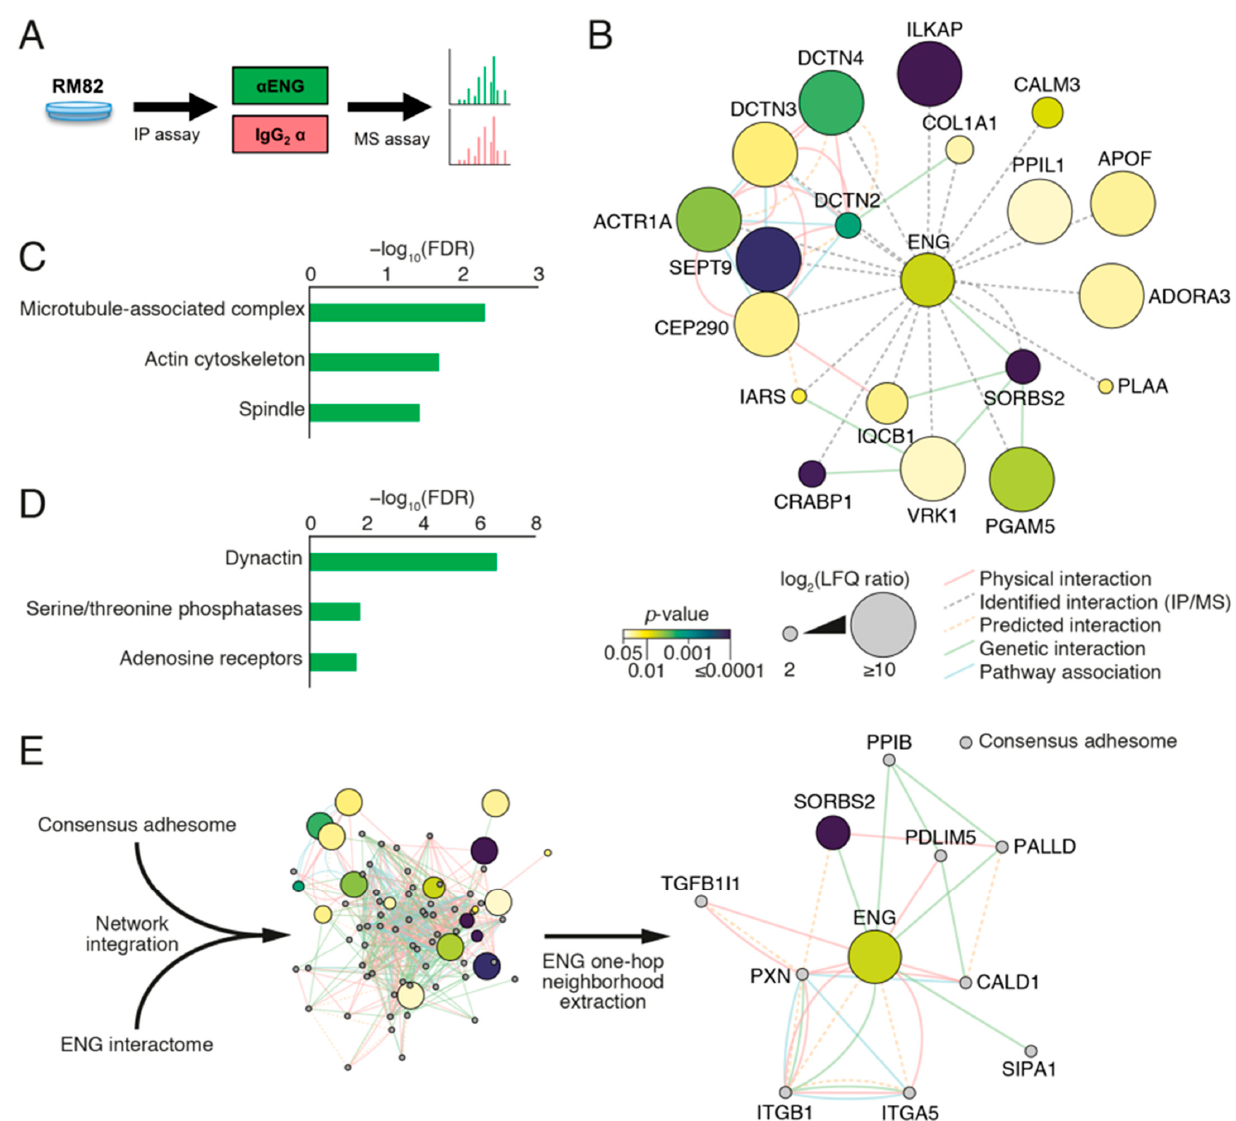
Figure 6. IP/MS identifies ENG-associated cytoskeletal and adhesion-related protein networks. ( A ) Workflow for the identification of potential interactors of ENG in RM82 WT cells by IP/MS. ( B ) Functional association network analysis of ENG-enriched interactors identified by IP/MS. Network edges (connecting lines) represent reported physical (red), genetic (green), pathway (blue), or predicted (dashed orange) interactions or imputed interactions detected by IP/MS (dashed gray). Nodes (circles) represent identified proteins. Node size is proportional to log 2 -transformed LFQ ratio (ENG/IgG); node fill color represents p -value of LFQ ratio (log 10 scale). Nodes annotated with gene names for clarity. ( C ) GO over-representation analysis of ENG interactors identified by IP/MS, analyzing the GO cellular component domain (non-redundant database). All terms over-repre- sented with FDR < 0.05 are shown. ( D ) Gene family enrichment analysis of ENG interactors identi- fied by IP/MS. All terms enriched with FDR < 0.03 are shown. ( E ) In silico network integration of the published consensus adhesome with the ENG interactome identified by IP/MS. The ENG one- hop neighborhood is shown, key as for B, and gray nodes indicate consensus adhesome components (not detected by IP/MS).